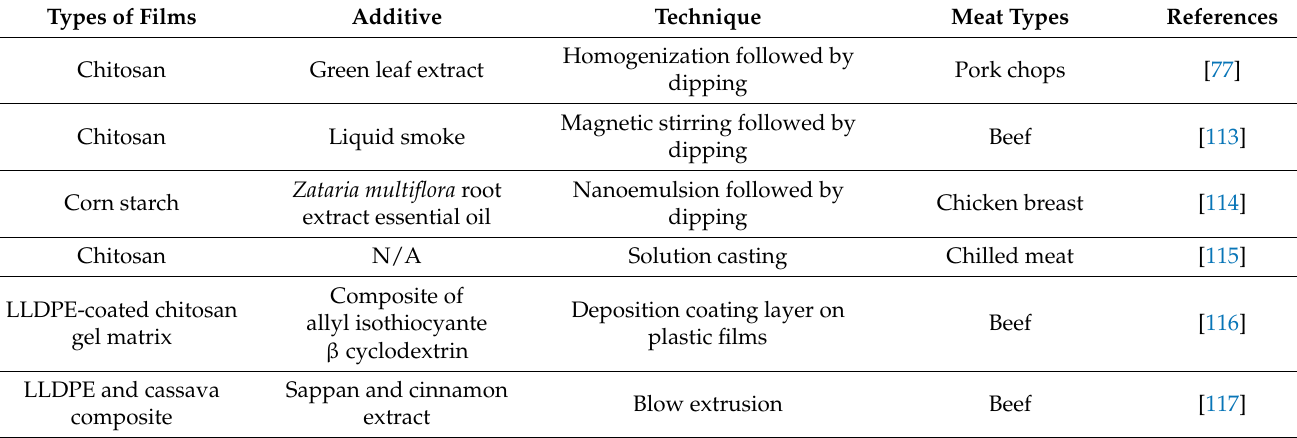
Table 1. A few examples of biodegradable films’ compositions, their preparation techniques, and applications in preserving various meat